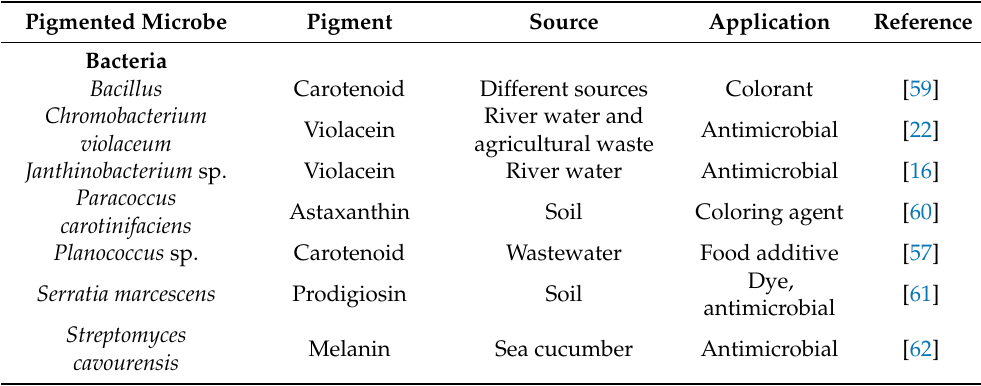
Table 1. Few examples of industrially important pigmented microbes isolated from various environ- ments and their